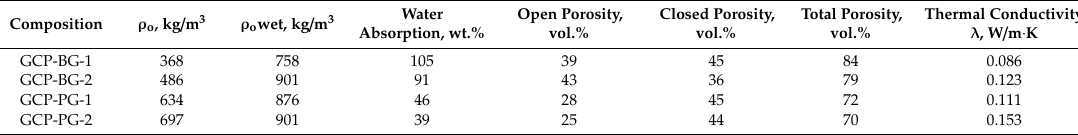
Table 5. Physical properties of foamed ternary system binder.